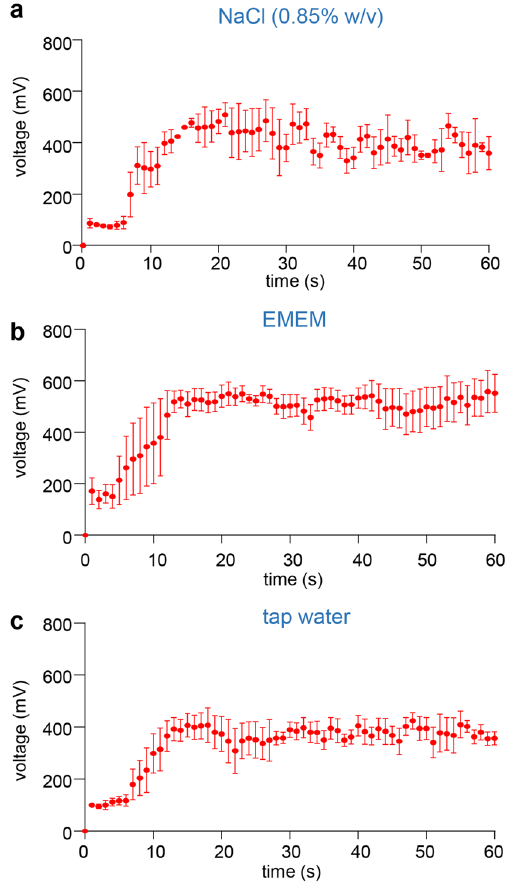
Figure 3. The electroceutical fabric. Voltage generated by electroceutical fabric was measured using the Amprobe multimeter in three different aqueous wetting solutions: ( a ) NaCl (0.85% w/v); ( b ) Incomplete EMEM, and ( c ) Tap water. DC voltage was measured as shown. Probes were placed adjacent Ag and Zn dots and at 0 s, 100 µl of the respective wetting solution were added to the electroceutical fabric. Three independent readings (each lasting for 1 min) were recorded for all three solutions and graphs were plotted with mean of these readings, showing the activation kinetics of the electroceutical fabric in response to these wetting solutions. Data are mean ±